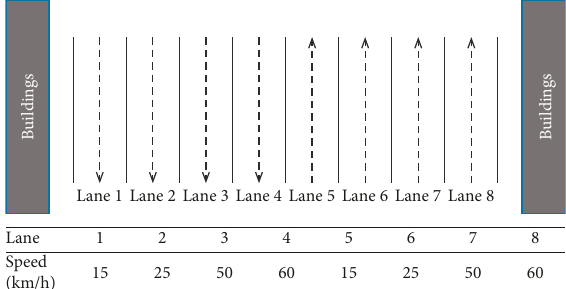
Figure 6: Vehicle speed in the 8-lane road (Area 2).